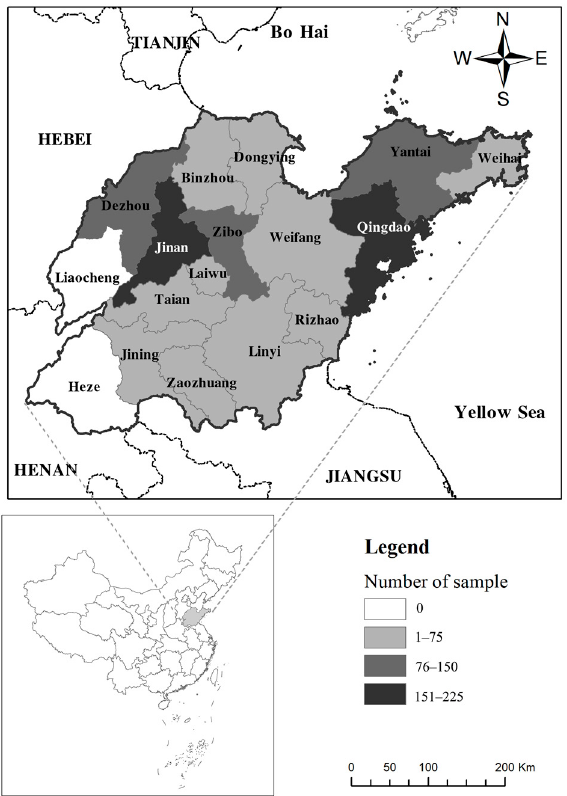
Figure 1. The number of samples used in our study (n = 1208) aggregated at the prefecture city level within Shandong Province.